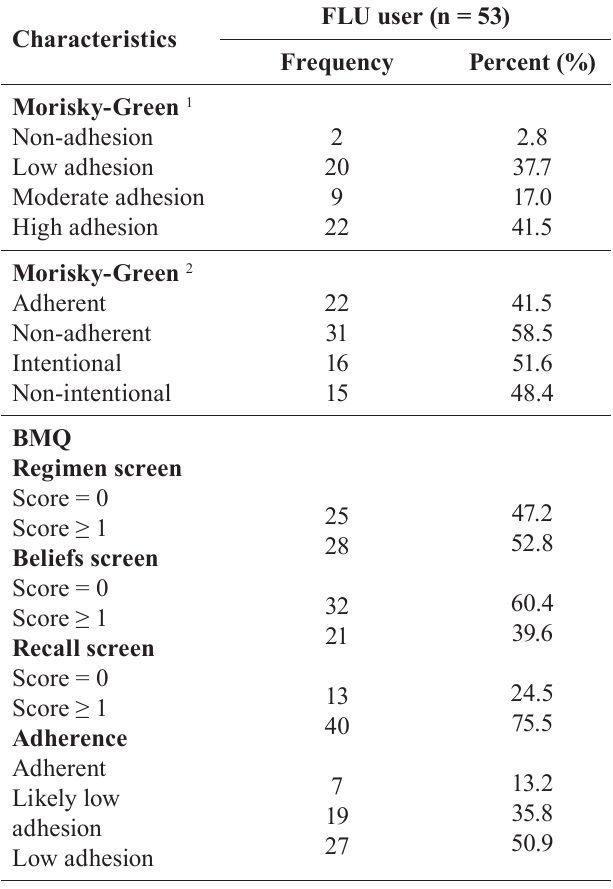
TABLE III - Classification of FLU users according to their adherence levels (using Morisky-Green and BMQ